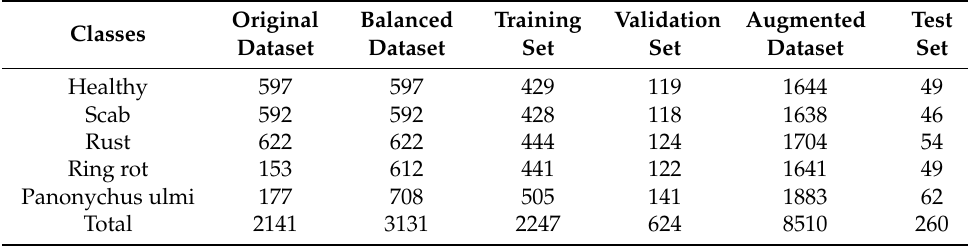
Table 1. The data